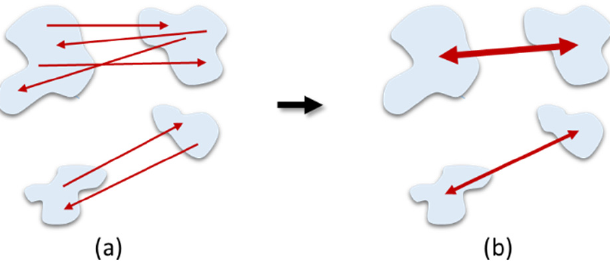
Figure 3. Edge weighting based on the geographic interactions between users: ( a ) edges from user movement flows between different geographic cells and ( b ) edges with weights from geographic interaction intensities.